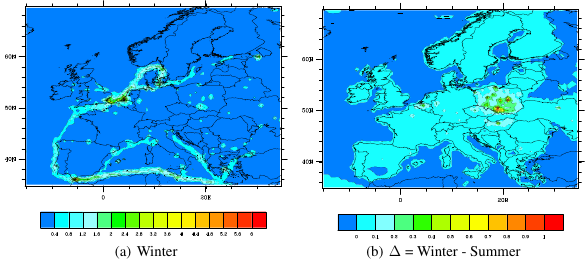
Fig. 6. Average sulfur dioxide emissions over Europe in winter, and Fig. 6 : Average sulfur dioxide emissions over Europe in winter, and difference ( ∆ ) between difference ( 1 ) between winter and summer, expressed inµgm − 2 winter and summer, expressed in µ g m − 2 h − 1 . h − 1